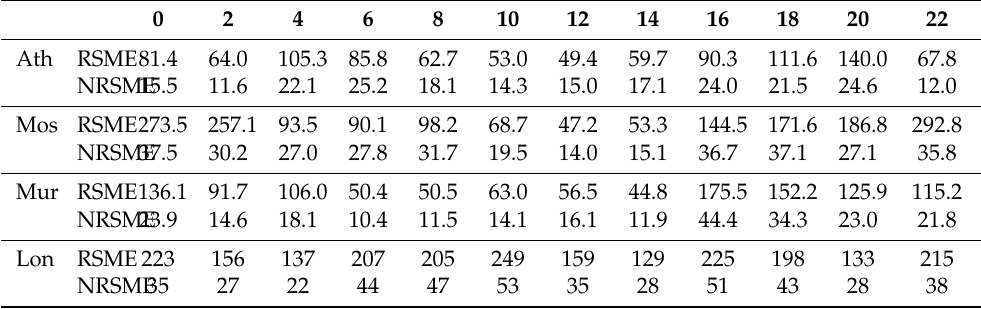
Table 1. τ metrics for four stations.